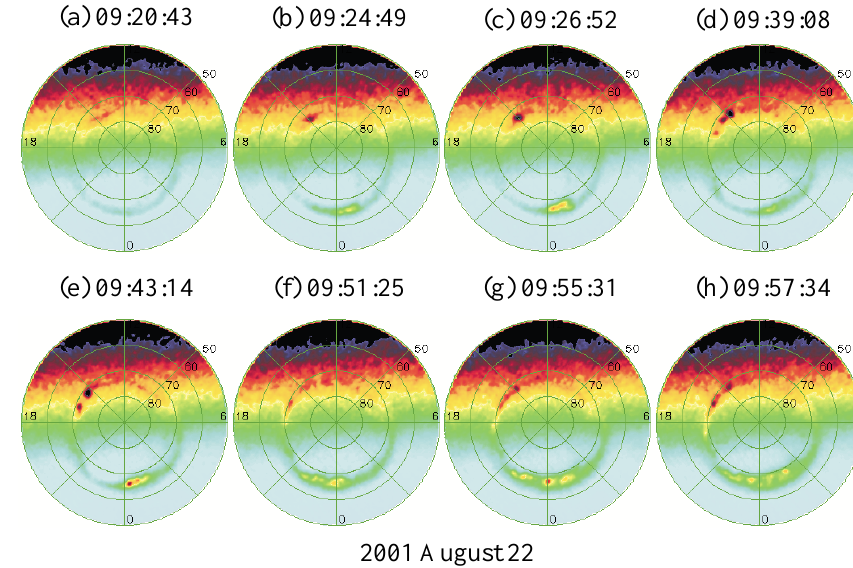
Fig. 2. Global auroral activity from IMAGE/FUV during the flow reversal interval.